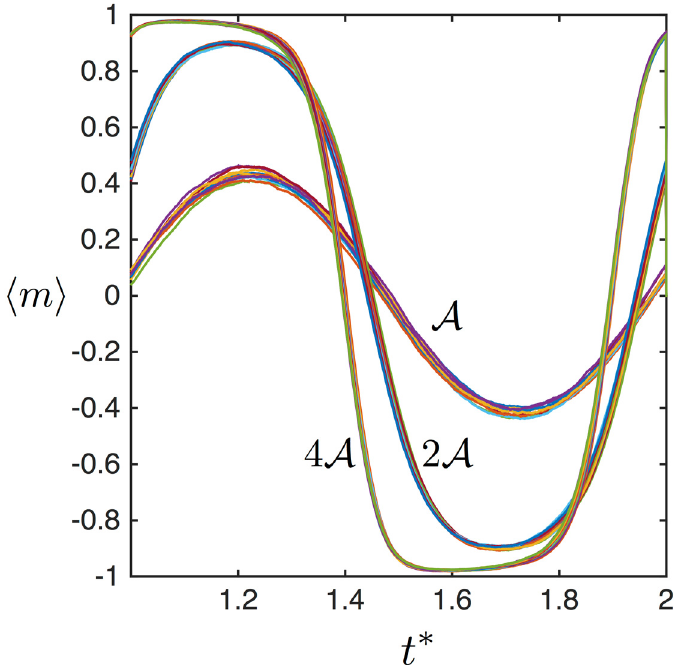
Fig 5. (Color online) Various values of the master variable lead to different dynamics. For each value of the master variable, ten different magnetizations, ranging by 10 K from 250 – 350 K, are plotted in order to demonstrate the stability to realistic temperature